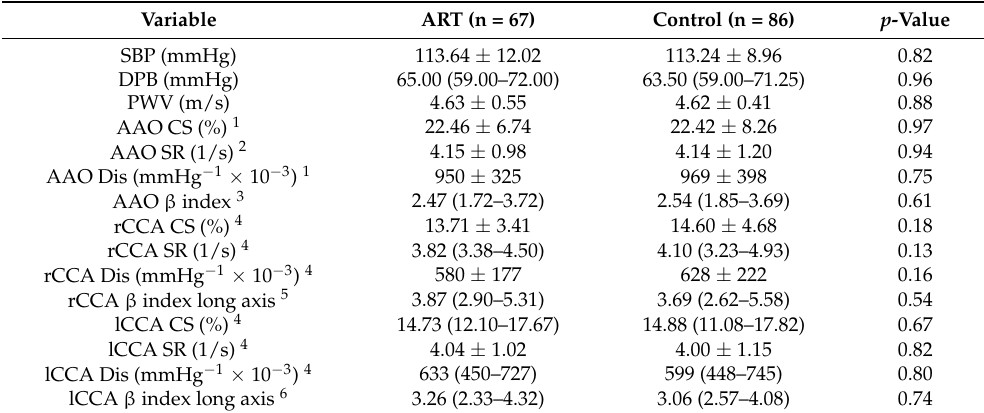
Table 2. Vascular Function in the ART and Control